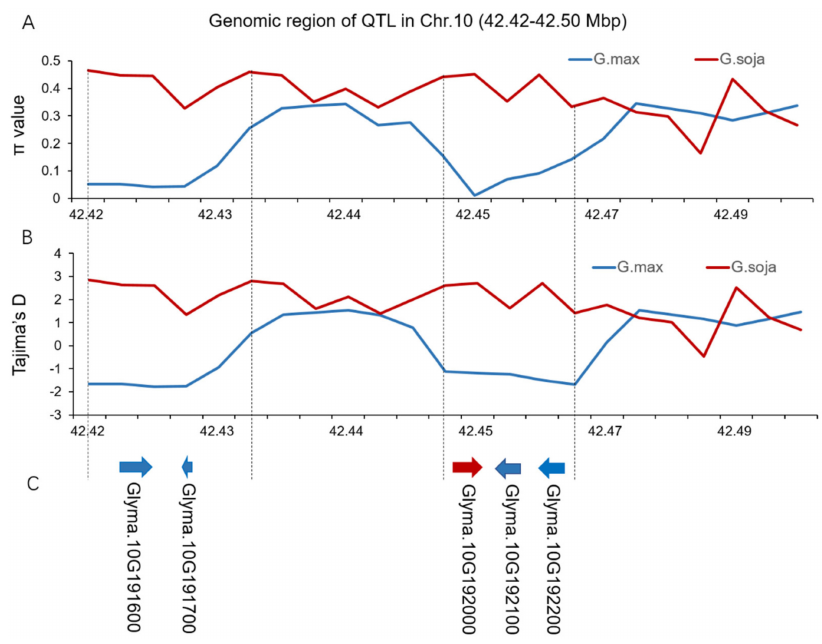
Figure 3. Genomic diversity of the qGI10 region. ( A ) Genetic diversity ( π ) of Glycine soja (the green line) and Glycine max (the blue line) in the qGI10 region; ( B ) Tajima’s D value of Glycine soja (the green line) and Glycine max (the blue line) in the qGI10 region; ( C ) Candidate genes in qGI10